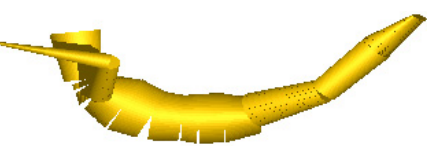
Fig. 5 Side view of Neutral Position ( α = 25 . 3